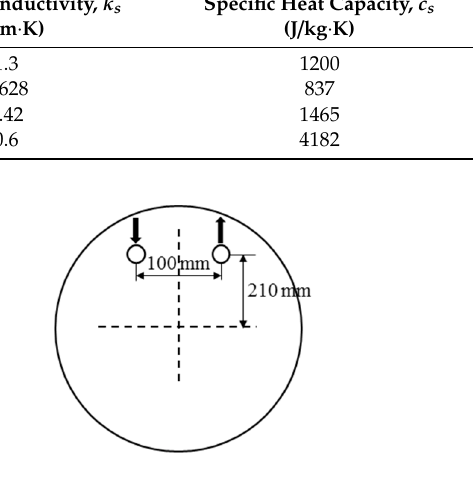
Figure 2. Tube positions at the pile head section.